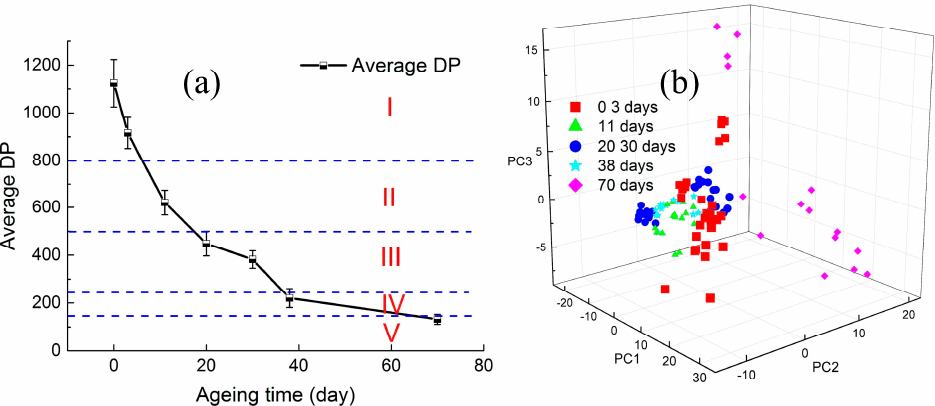
Figure 9. Classification results of testing samples: ( a ) Relationship between DP and aging time; ( b ) Scatter plots of the PC scores for five classes of oil samples, with the PC scores derived from the Raman spectra.